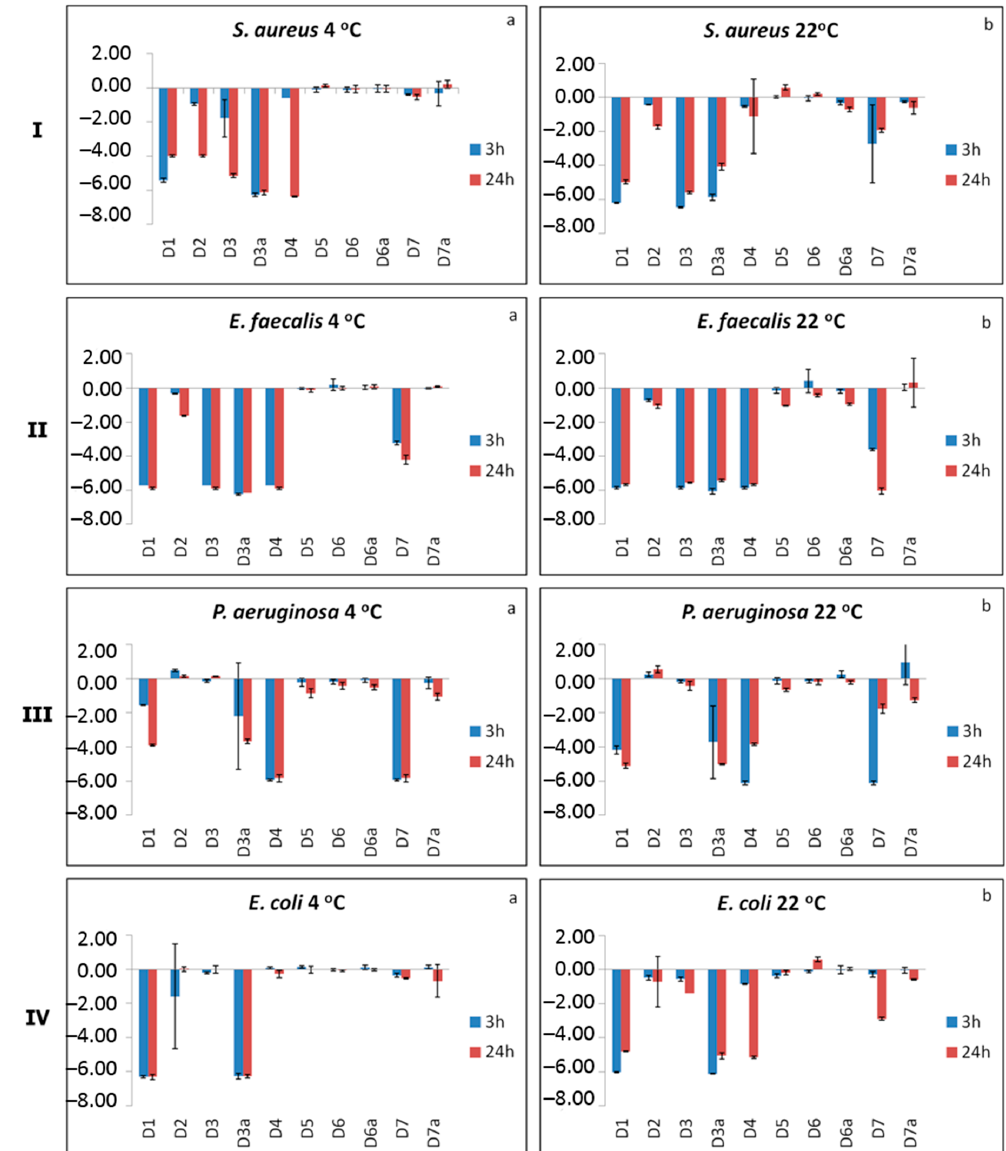
Figure 3. Bacteriostatic effect of polymers after 3 h and 24 h of contact with ( I ) S. aureus ; ( II ) E. faecalis ; ( III ) P. aeruginosa and ( IV ) E. coli at temperature 4 °C ( a ) and 22 °C ( b ). Each bar represents the log reduction from three independent experiments done in duplicates (mean ± standard deviation).